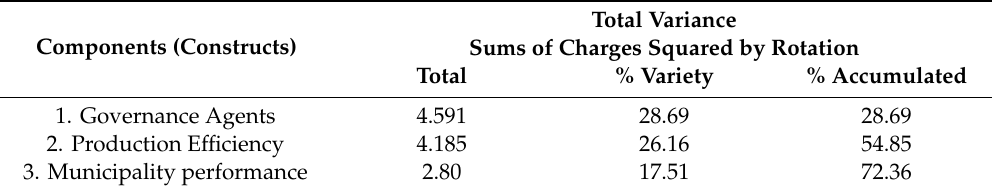
Table 3. Definition of components and percentage of explained